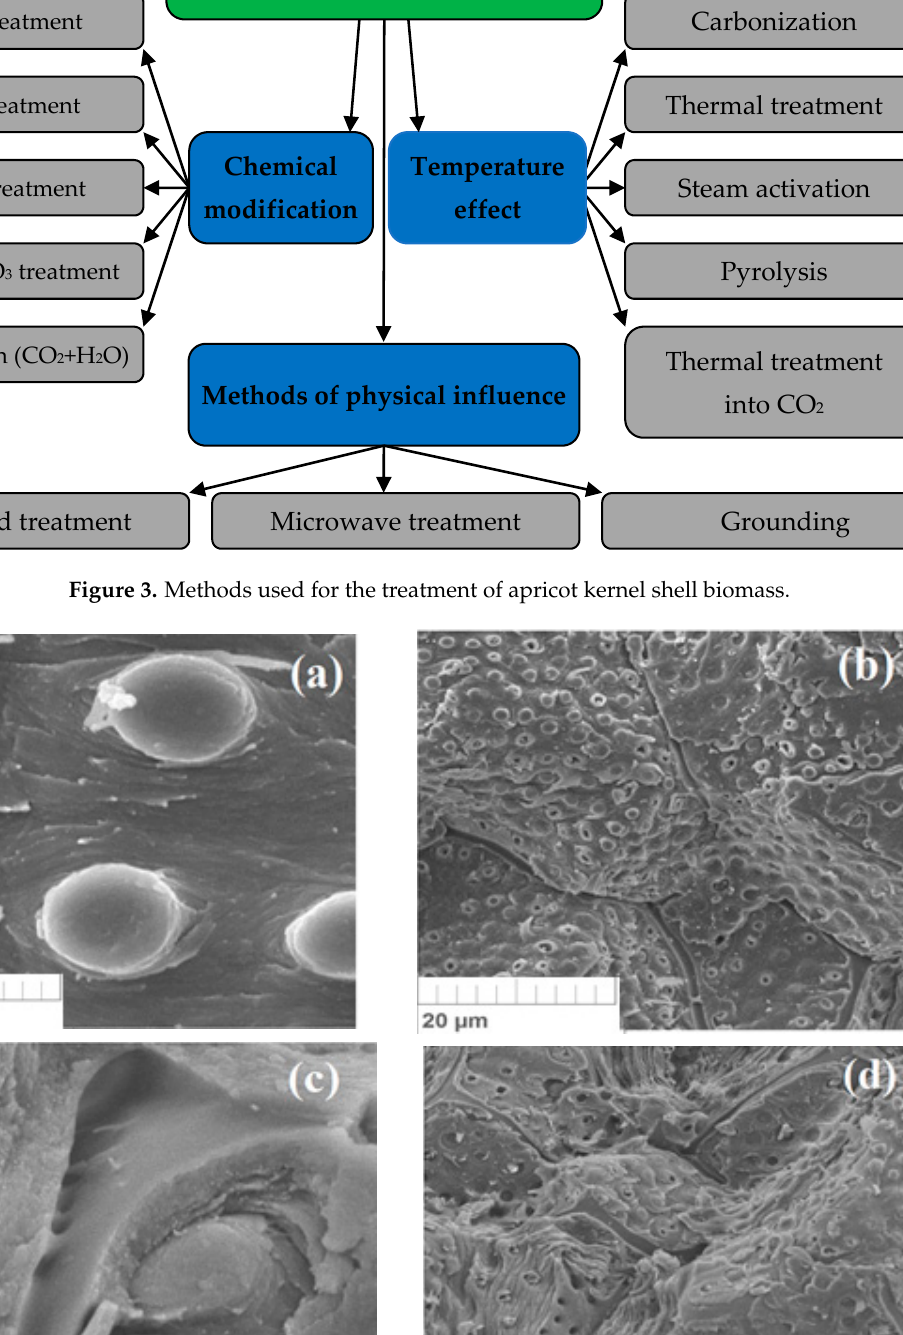
Figure 3. Methods used for the treatment of apricot kernel shell biomass.